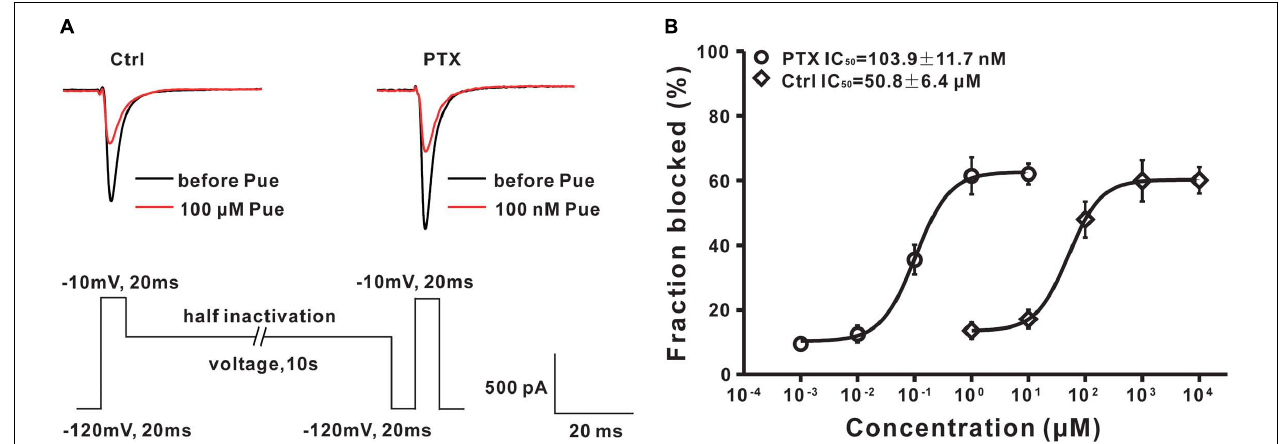
FIGURE 4 | Puerarin preferentially blocks inactivated Na v channels in DRG neurons of paclitaxel (day 10) rats (Ctrl, control; PTX, paclitaxel; Pue, puerarin). (A) The representative current traces were recorded before and 15 min after puerarin application at indicated concentrations and the protocol for the inactivation of Na v channels. (B) IC 50 values of puerarin on inactivated Na + currents of DRG neurons in control ( n = 9 neurons in each data point) and paclitaxel ( n = 9 neurons in each data point) groups.